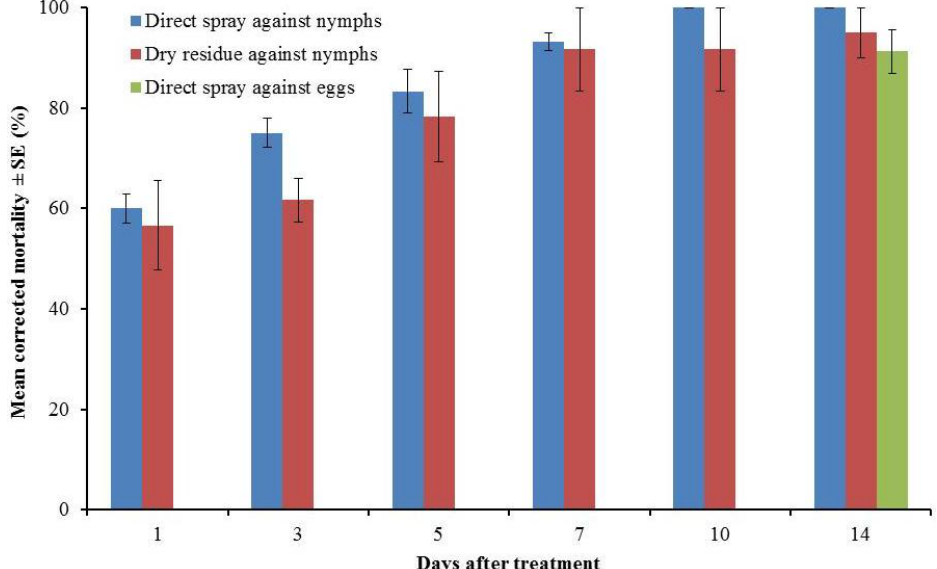
Figure 2. Efficacy of Alpine aerosol against Indy strain bed bugs in direct spray and dry residue exposure